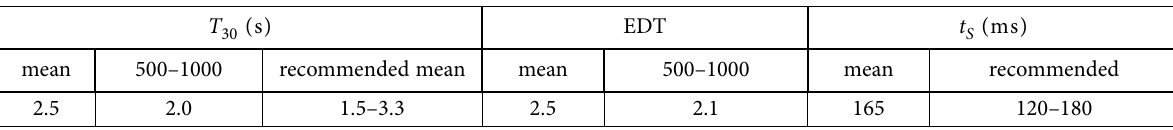
Table 7. Values of acoustic parameters T 30 , EDT and t S obtained in the simulation after acoustic treatment including recommended values T 30 (s) EDT